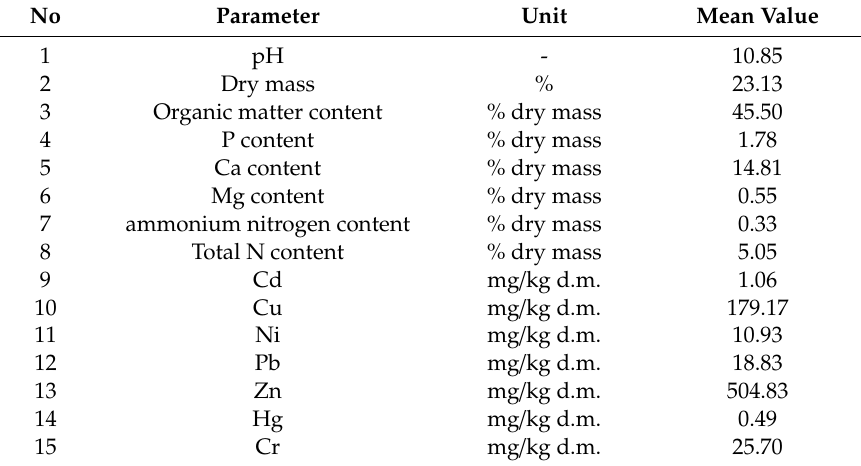
Table 1. Physical and chemical parameters of the stabilized sewage